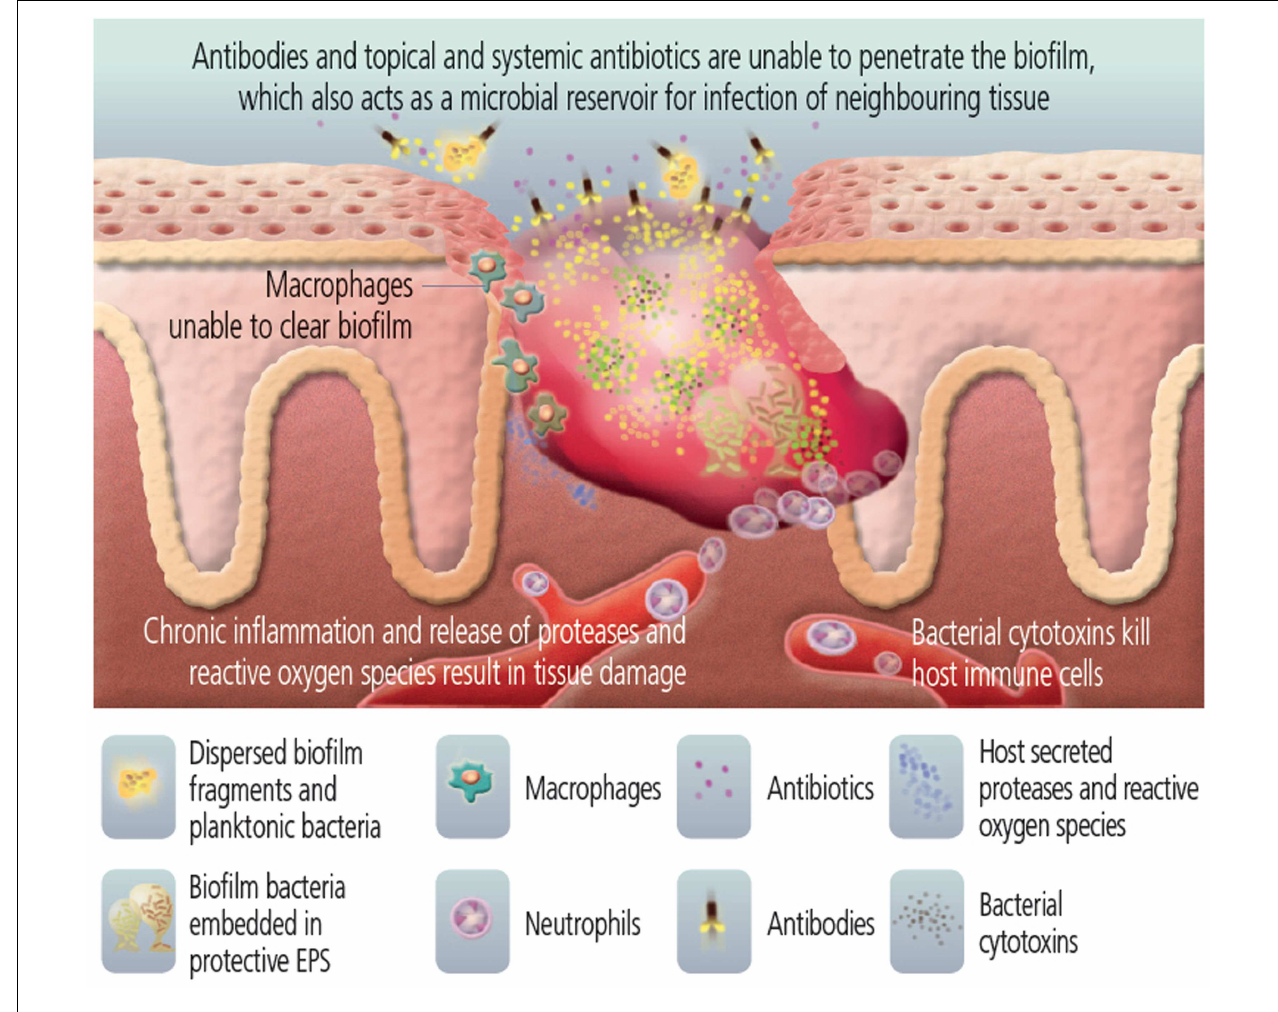
FIGURE 3 | Bacteria in the wound are protected by biofilm . [Image used with permission from Biofilms Made Easy, 2010,Vol. 1, Issue 1, published on Wounds International (http://www.woundsinternational.com/pdf/content_8851.pdf)].